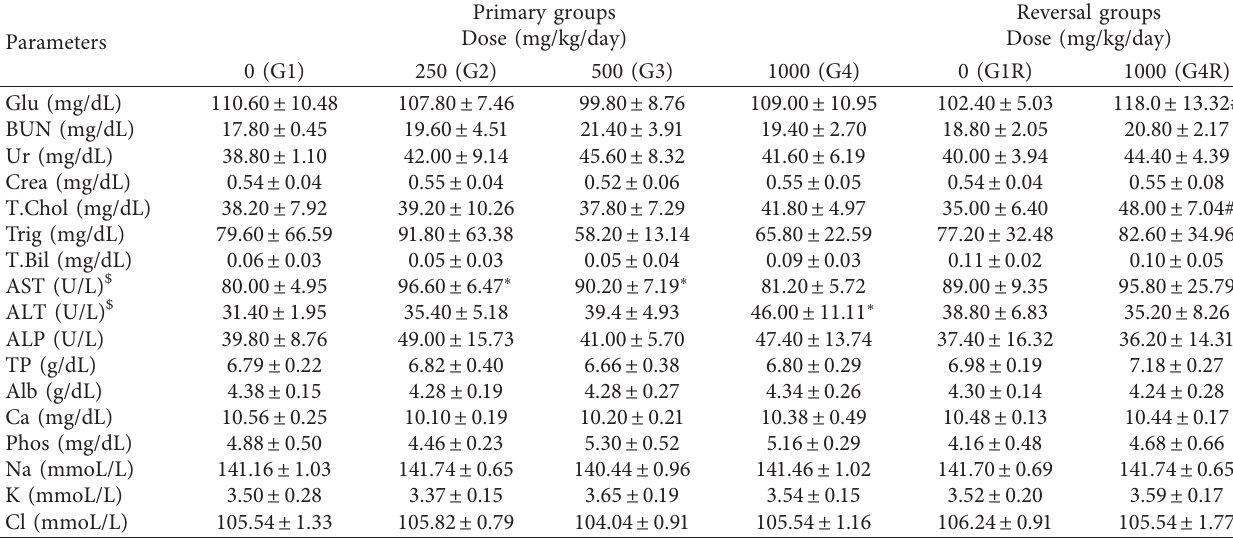
Table 10: Effect of oral administration of GMCT on biochemical parameters in female Wistar rats.